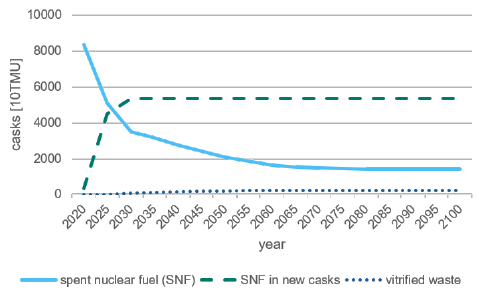
Figure 10. Overall storage levels of different types of waste. Source: own representation.